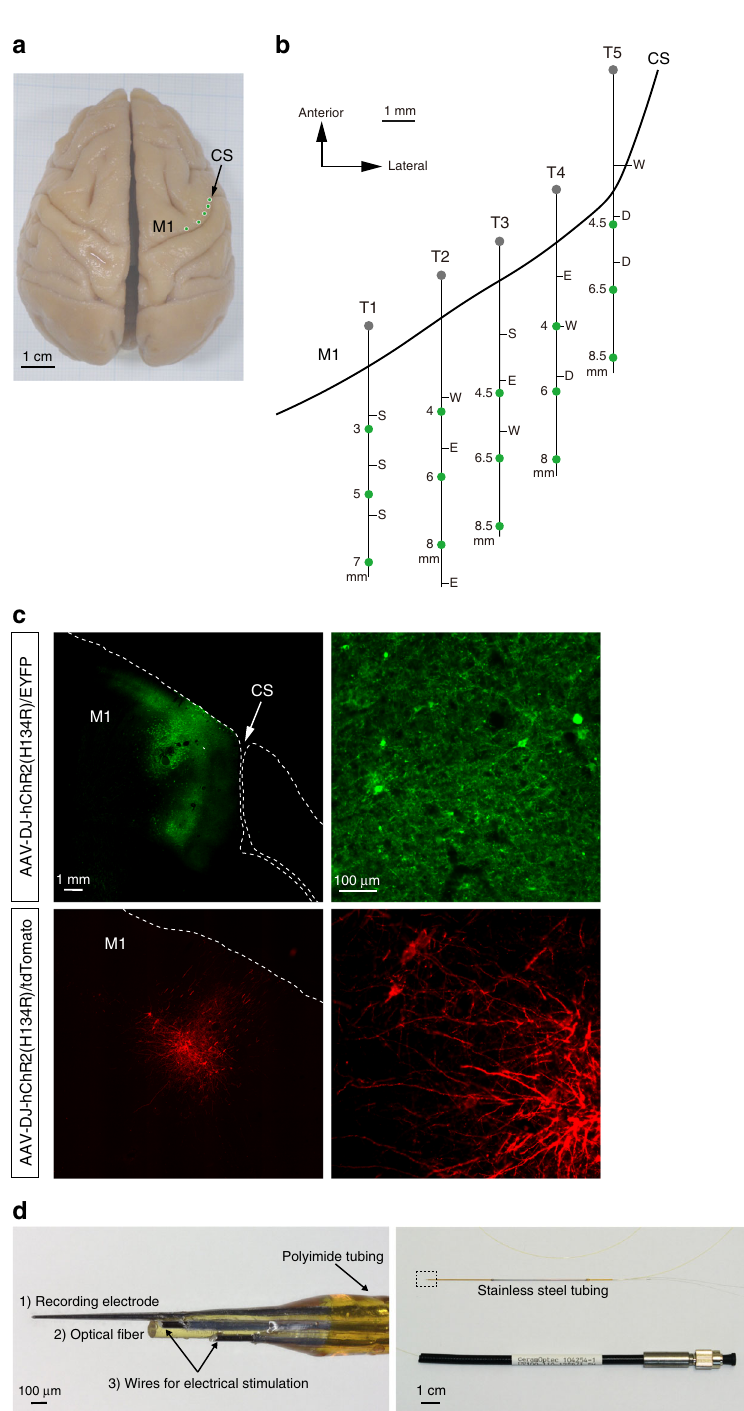
Fig. 1 Mapping of the motor cortex expression of ChR2, and construction of the optrode. a Top view of the whole brain of a macaque (Monkey HJ). Green circles indicate penetration sites for AAV injections. CS central sulcus, M1 primary motor cortex. b Electrophysiological mapping of the right M1 (Monkey HJ). Somatotopic arrangement in the anterior bank of the CS is shown along with depths from the cortical surface. Each letter indicates a somatotopic body part: D digit, E elbow, S shoulder, W wrist. The AAV vector was injected in the sites indicated by the green circles. c Expression of hChR2(H134R)/EYFP and of hChR2 (H134R)/tdTomato mediated by AAV-DJ vectors in the M1 shown in frontal sections (Monkey NR). These experiments were repeated three times independently (Supplementary Table 1), with similar results obtained. d Photograph of the tip (left) and whole view (right) of the optrode. (1) A glass-coated tungsten electrode for recording, (2) an optical fi ber for optical stimulation and (3) a pair of tungsten wires for bipolar electrical stimulation were bundled and inserted into polyimide tubing (left). The base of the optrode was covered with stainless steel tubing (right). The other end of the optical fi ber was jacketed with a protective tubing with a length of around 15cm and had a fi ber-optic connector. The rectangular area in the right photograph is enlarged in the